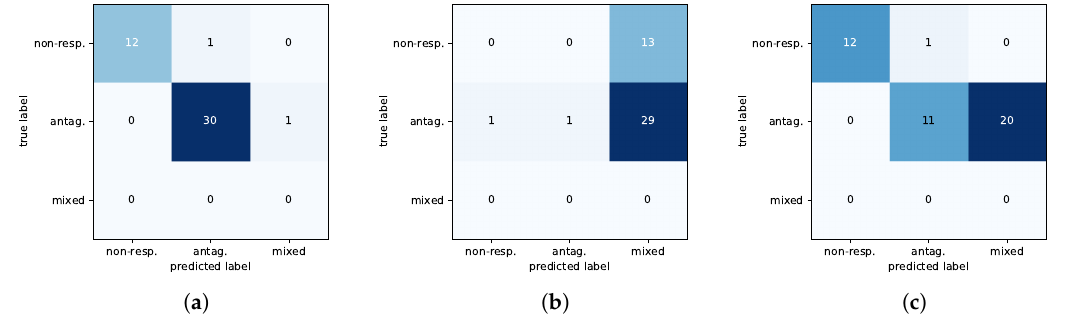
Figure 5. Confusion matrices for darolutamide predictions and experimental validation. Predicted classes are along the x-axis with the true class on the y-axis. The agonist class is dropped as no mutants showed this phenotype with darolutamide, and no models predicted this class. ( a ) DNN. ( b ) RF. ( c )